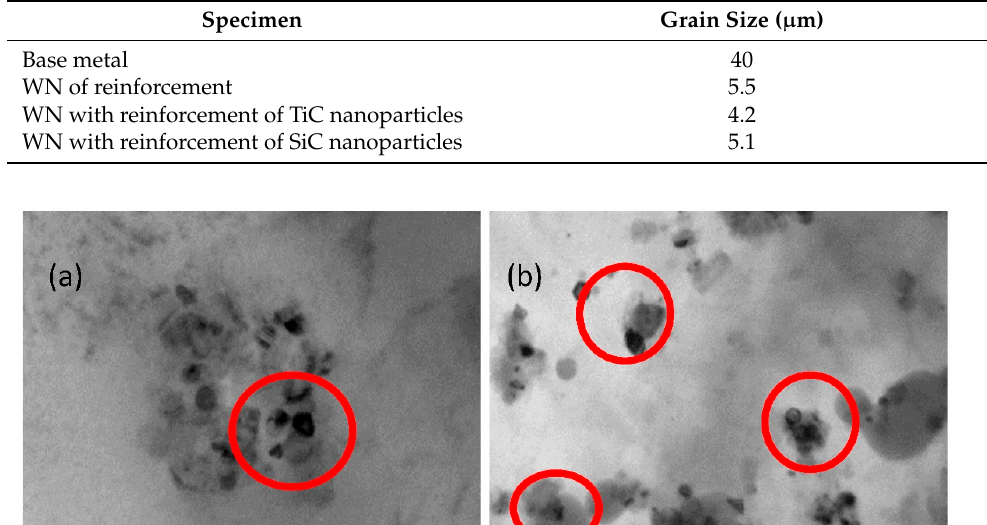
Table 2. Grain size in the weld nugget.